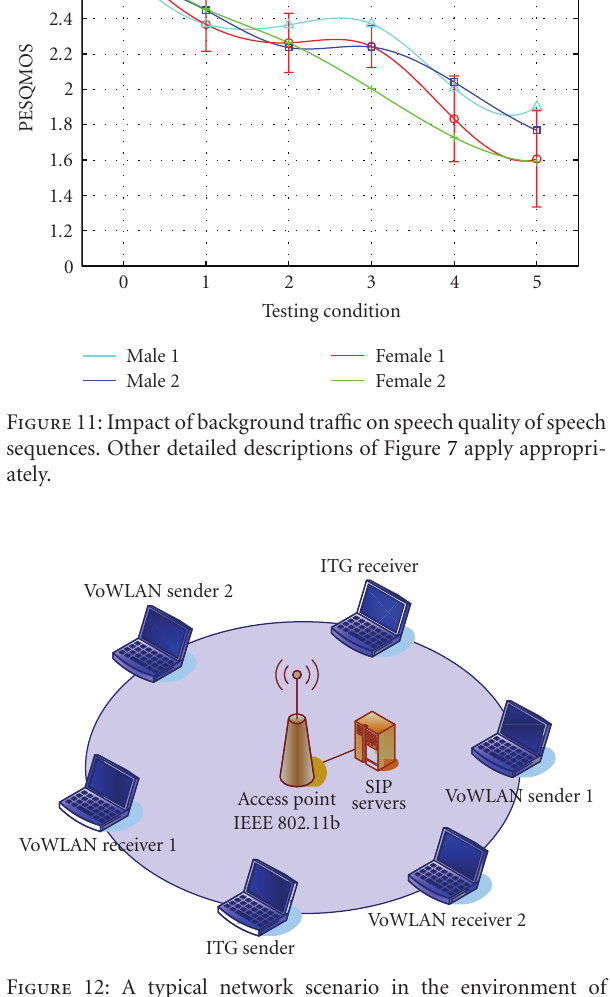
Figure 12: A typical network scenario in the environment of